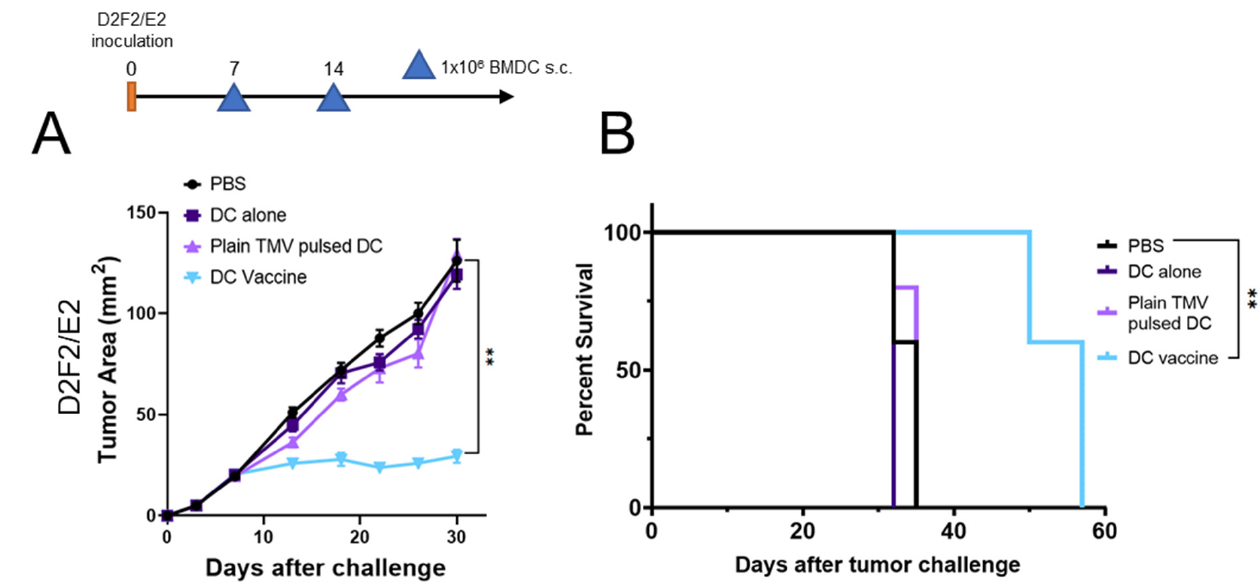
Figure 4. DC vaccine inhibits D2F2/E2 tumor growth and increase the survival of mice. ( A ), BALB/c mice ( n = 5 per group) were inoculated with 2 × 10 5 D2F2/E2 cells s.c. on the flank. BMDCs were pulsed for 24 h with D2F2/E2 TMV (Plain TMV pulsed DC), or D2F2/E2 TMV incorporated with GPI-IL-12 and GPI-GM-CSF (DC vaccine) and administered at day 7 and 14 s.c. on the contralateral flank (1 × 10 6 DCs/dose). ( B ), survival of tumor bearing mice is shown. p < 0.01 **. ( A ) was analyzed with a two-way ANOVA with Tukey’s post-test for multiple comparisons, error bars represent SEM. Log-rank (Mantel-Cox) test was used to determine significance in survival of mice.